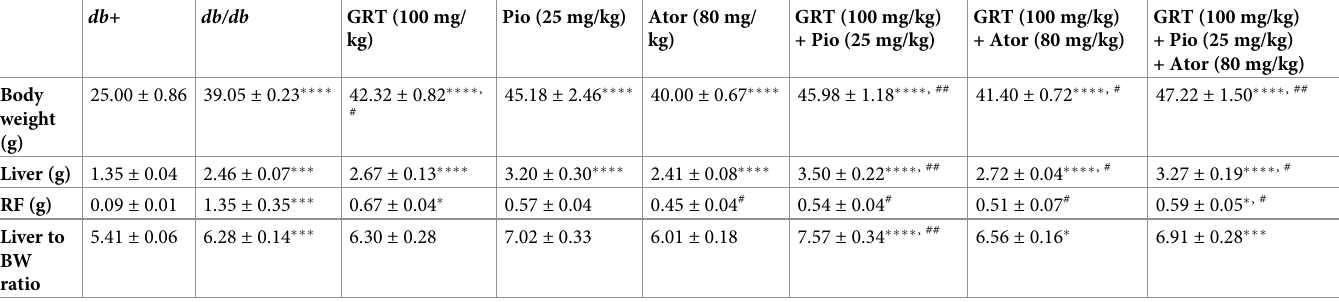
Table 1. Body weight and liver weight changes of mice orally treated with GRT, pioglitazone, and atorvastatin as mono- and co-therapies for 5 weeks. db+